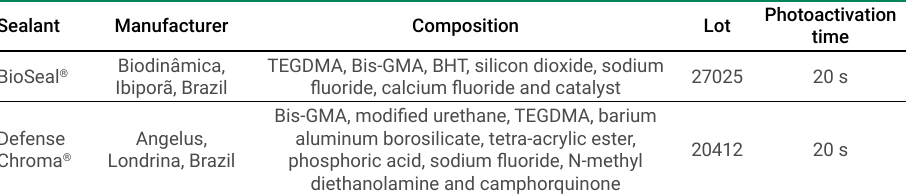
Table 1. Composition of resin-based sealants used in the present study.